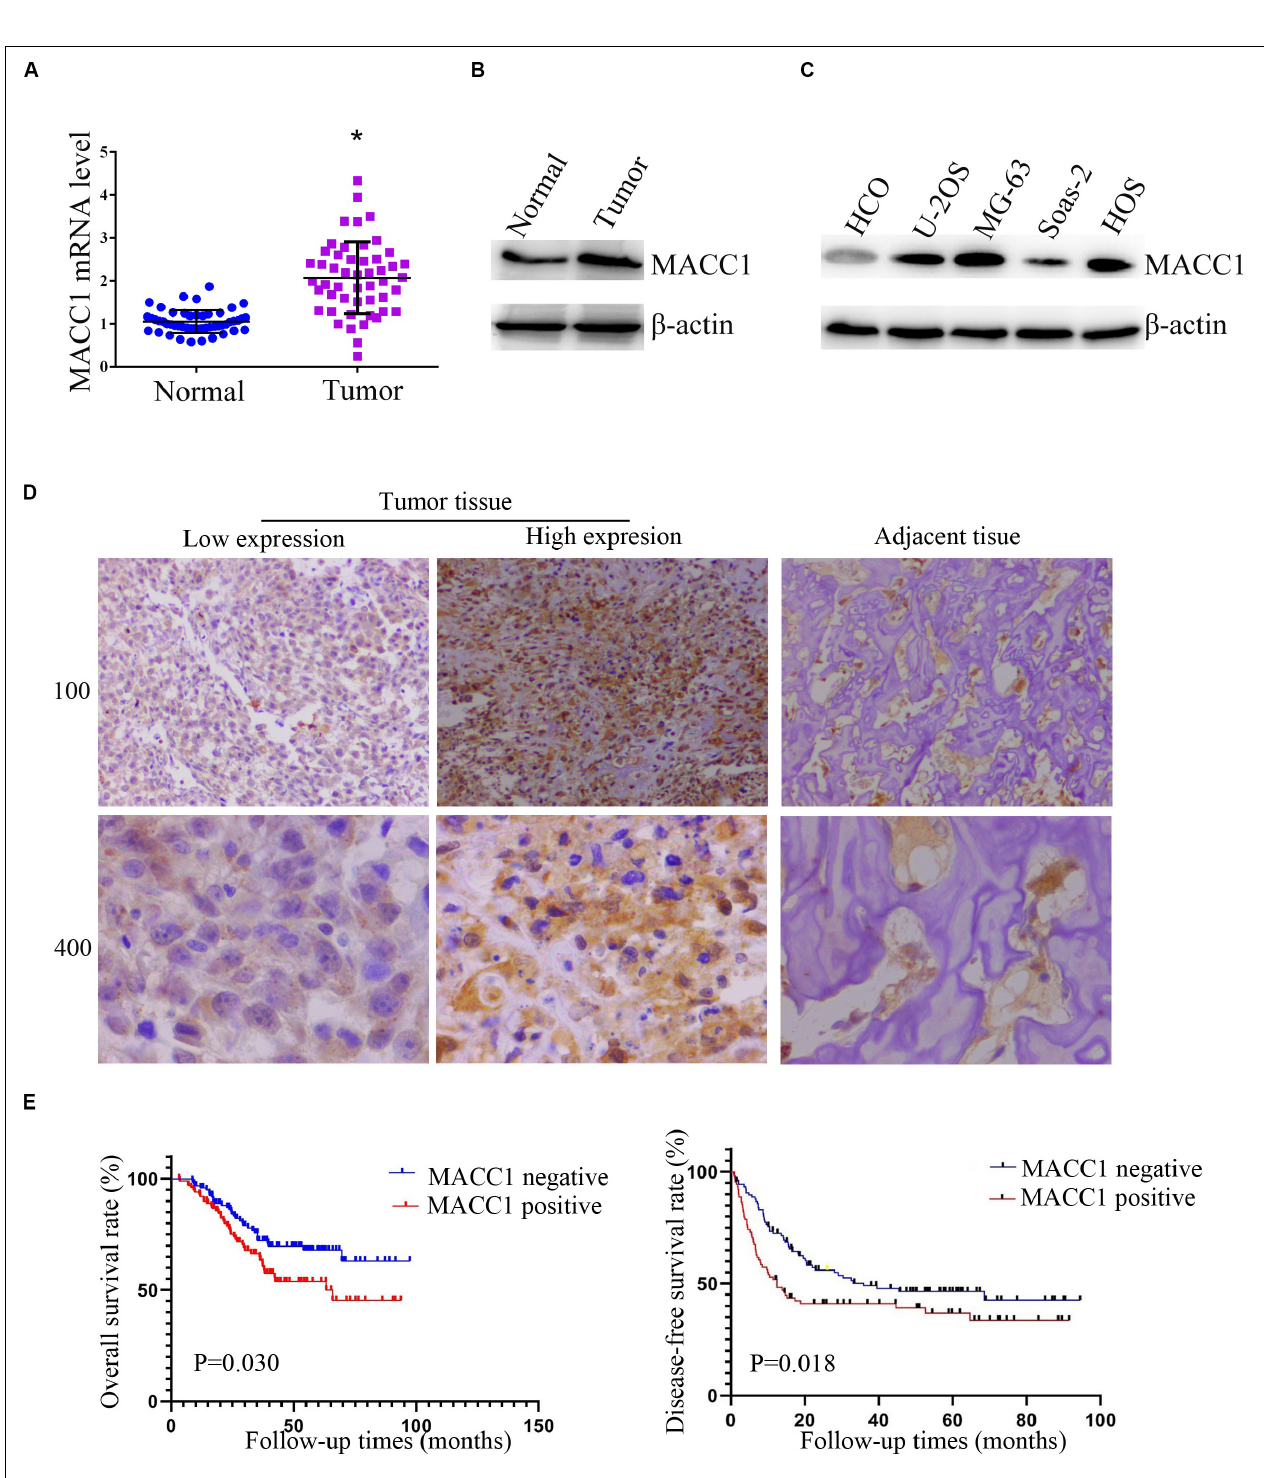
FIGURE 1 | MACC1 is highly expressed in human osteosarcoma (OS) tissues and cell lines and its expression correlates with prognosis in OS patients. (A) Quantitative PCR assays were conducted to measure the MACC1 mRNA levels in OS tissues and the corresponding adjacent noncancerous tissues ( n = 30). (B) Immunoblot assays were conducted to detect the protein levels of MACC1 in OS tumor tissues and the corresponding adjacent noncancerous tissues. (C) Immunoblot assays were conducted to measure the protein levels of MACC1 in the U-2OS, MG-63, Saos-2, and HOS osteosarcoma cell lines, and normal human umbilical vein endothelial cells (HUVECs). (D) Immunohistochemistry was performed to measure the protein levels of MACC1 in human OS tissues and the corresponding adjacent noncancerous tissues; representative images are shown ( × 100 and × 400 magnification, respectively). (E) Kaplan–Meyer survival analysis showed the correlation between MACC1 expression in tumor tissues and overall survival or disease-free survival rates.